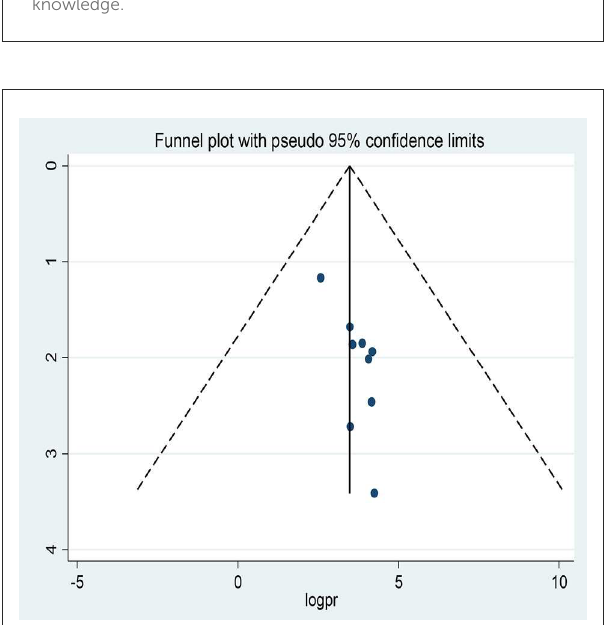
FIGURE7 Funnel plots of publication bias for a good level of epilepsy knowledge.